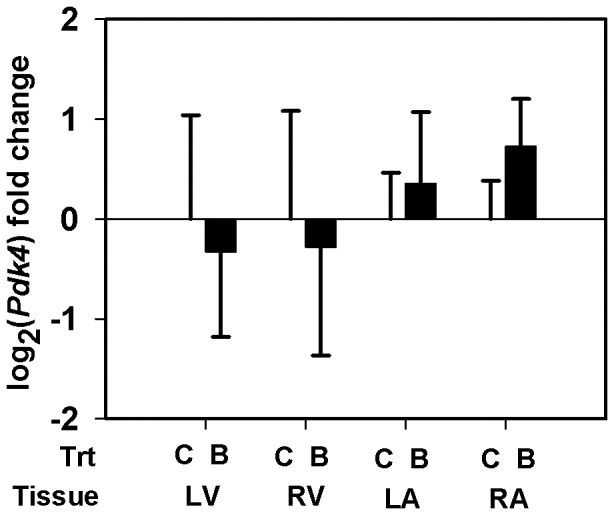
Pyruvate dehydrogenase kinase isozyme 4 (Pdk4) mRNA expression.Real-time PCR quantification of Pdk4 gene was performed on the left ventricle (LV), right ventricle (RV), left atrium (LA) and the right atrium (RA) samples of rhesus monkey (Macaca mulatta) fetuses at birth. Fetuses were exposed maternally to a 400 µg/Kg. body weight of BPA dose (B) or 150 µL ethanol (C) during late gestation (LG, days 100±2–term). Data were analyzed by tissue and bars represent the mean ± S.E.M. of the log2 (fold change). A two sample t-test was performed to identify significant BPA effects and a two-tailed p≤0.05 was considered statistically significant.